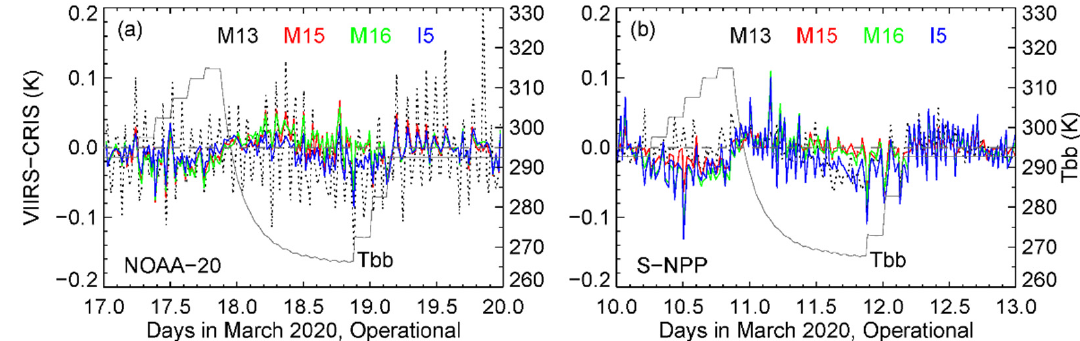
Figure 10. NOAA-20 ( a ) and S-NPP ( b ) M13, M15-M16, and I5 VIIRS–CrIS BT difference time series during the March 2020 WUCD events, after the implementation of the operational TEB WUCD bias correction. OBCBB temperatures ( T bb ) were plotted in the background (gray color).